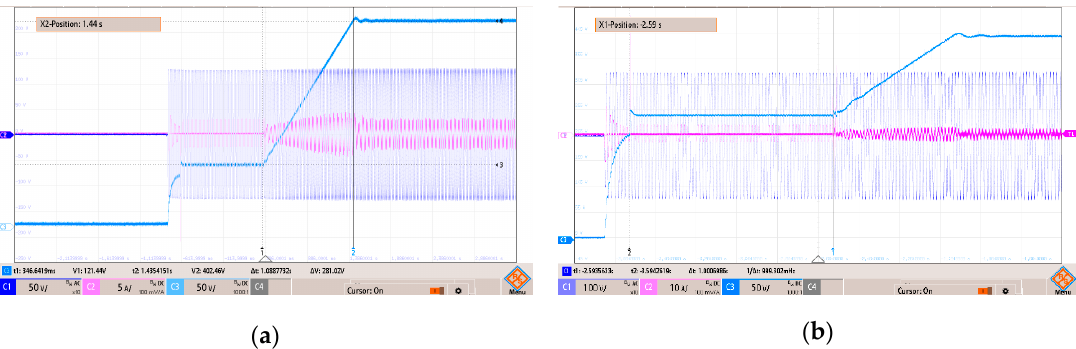
Figure 12. Start-up waveforms of the totem-pole PFC ( a ) at 90 VAC with 300 mA load current; (V AC 50 V / division in AC coupling mode, channel 1– I L 5 A / division, channel 2– V OUT 50 V / division, channel 3. Timebase 500 ms / division) ( b ) at 230 VAC with 300 mA load current (V AC 100 V / division in AC coupling mode, channel 1– I L 10 A / division, channel 2– V OUT 50 V / division, channel 3. Timebase